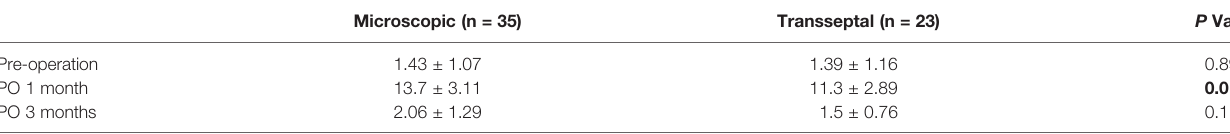
TABLE 3 | SNOT-22.